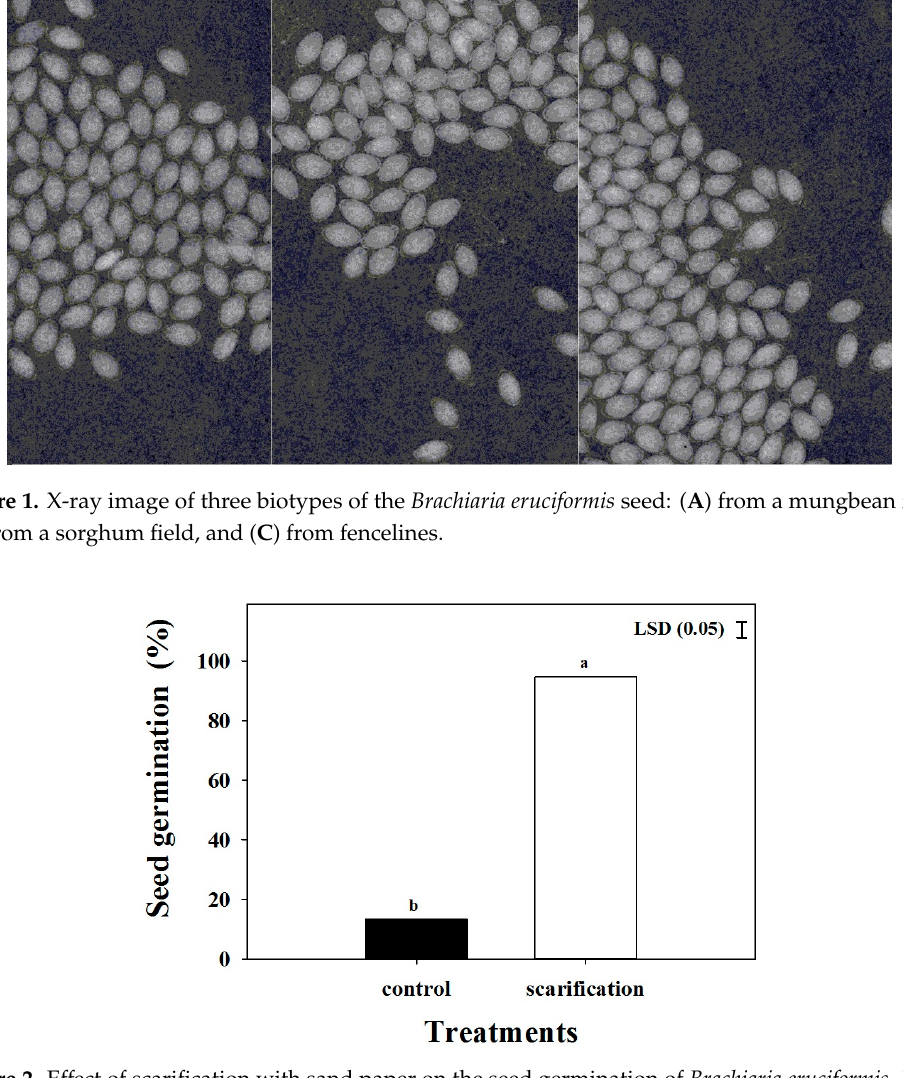
Figure 2. Effect of scarification with sand paper on the seed germination of Brachiaria eruciformis . Each bar of the graph represents a mean value of germination data (pooled across biotypes) as no significant differences were observed among biotypes. The vertical bar shows the least significant difference (LSD) values at the 5% level of probability.